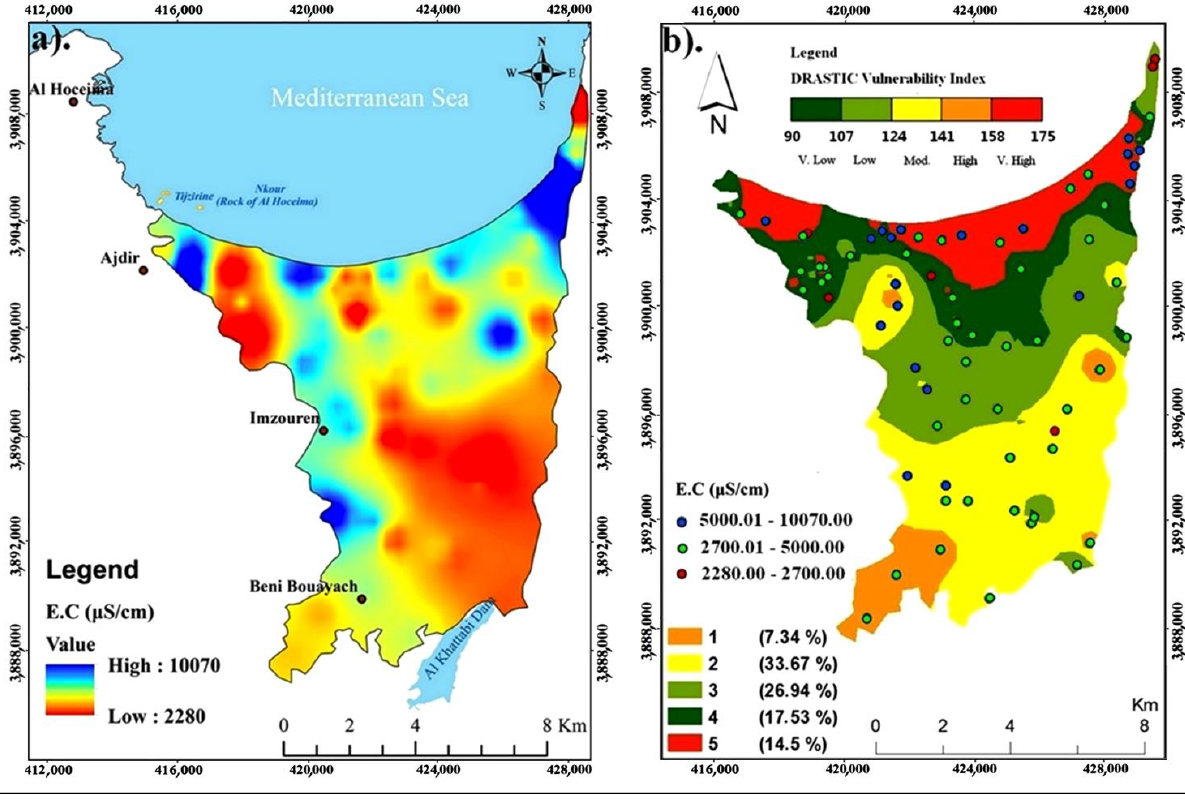
Figure 7. ( a ) Spatial distributions of EC in groundwater. ( b ) Original vulnerability map and EC conductivity for the study area. conductivity for the study